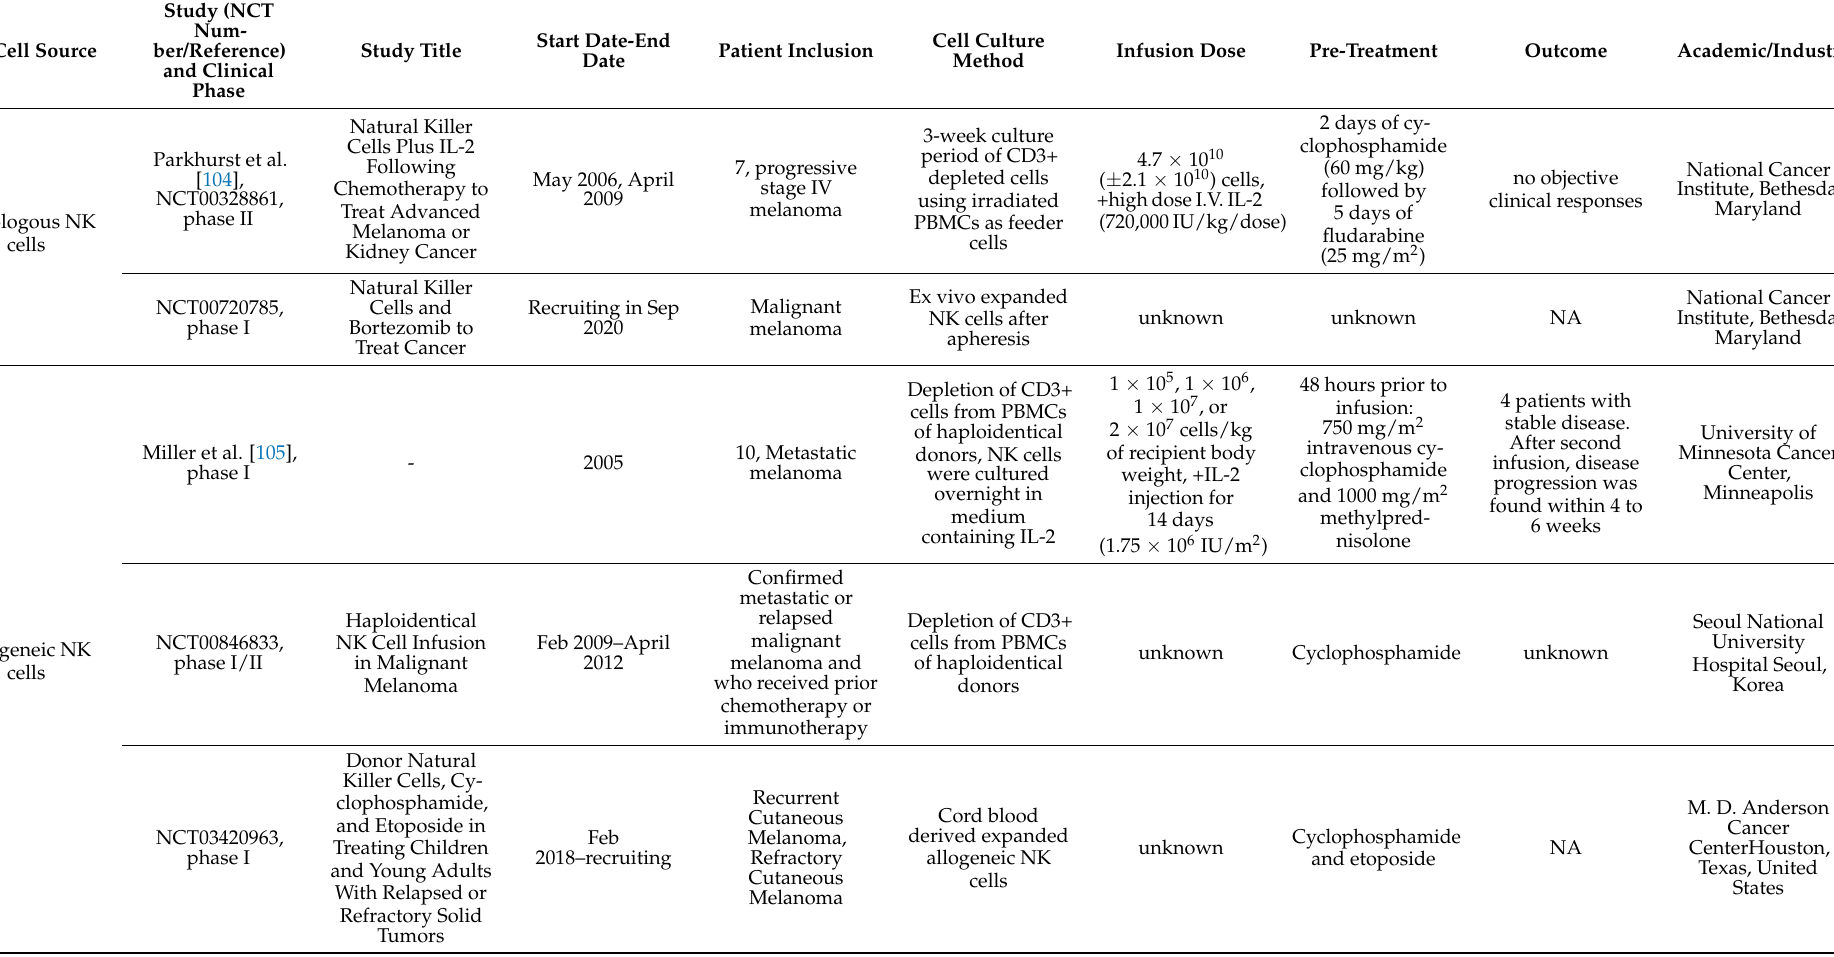
Table 1. Overview of clinical trials using NK cells for the treatment of